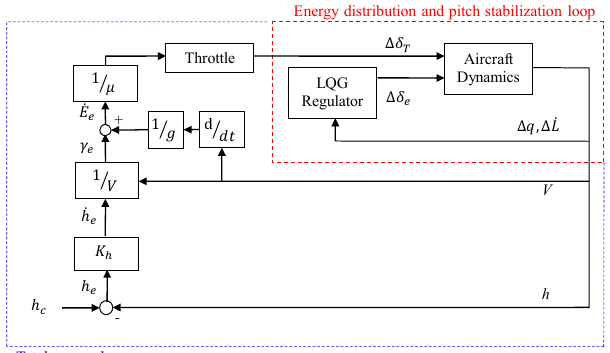
12 of 24 Figure 8. Curve fit relation of ∆(cid:1831) (cid:2929) (cid:4662) and ∆δ T . 4. Optimal Energy Control System 4.1. OECS Design In this study, an OECS has been proposed to form the aircraft longitudinal flight control system and to control the airspeed and altitude of the aircraft. There are two parameters, specific energy distribution rate, (cid:1838)(cid:4662) (cid:2929) , and total specific energy rate, (cid:1831)(cid:4662) (cid:2929) , utilized to characterize the energy of an aircraft or UAV. The block diagram of the proposed OECS is shown in Figure 9. The block diagram of the total energy loop is used to perform the tracking of aircraft altitude. Altitude tracking begins with the commanded altitude, ℎ (cid:2913) . The difference between the commanded altitude and the current altitude of the aircraft, h , is the altitude error, ℎ (cid:2915) which in turn will be scheduled by gains, (cid:1837) (cid:3035) . The values of (cid:1837) (cid:3035) were decided according to the tests of flight simulations. Table 3 shows the gains used